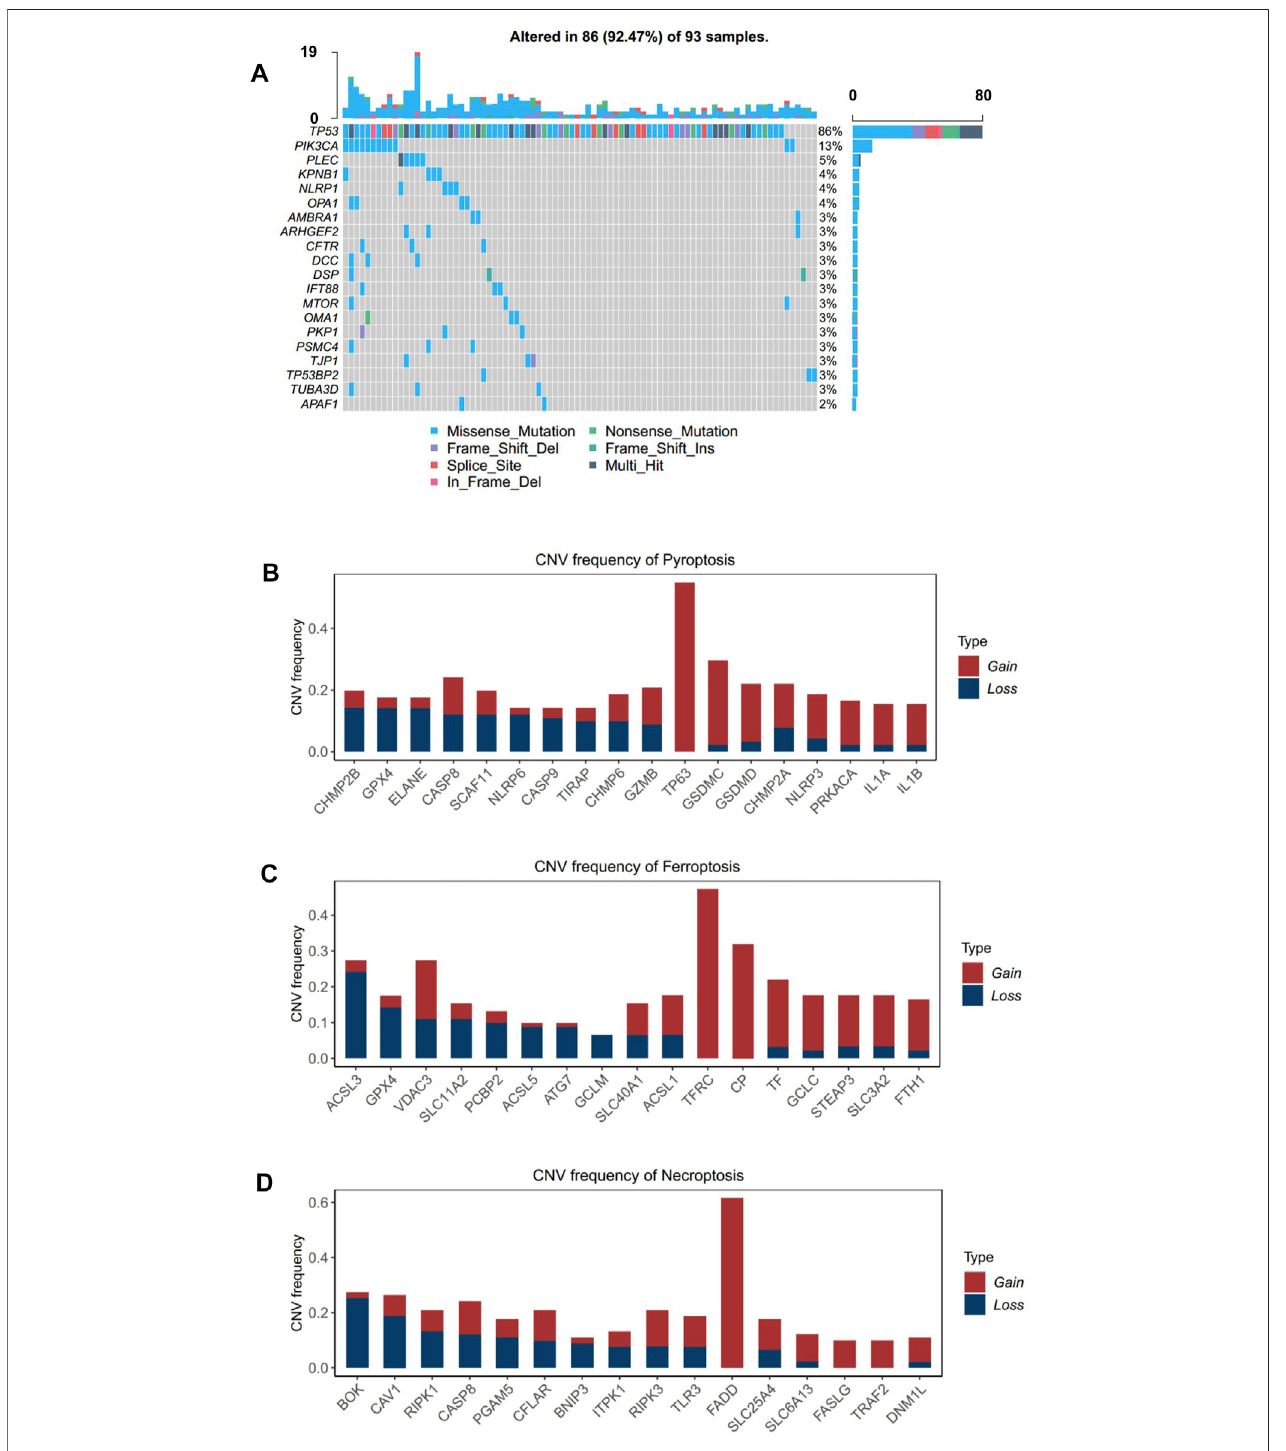
FIGURE 2 | Landscapeofgenetic alterations ofcelldeath genes inESCC. (A) Mutation frequencyofcelldeath genesin91patientswithESCCfromtheTCGA-ESCC cohort.Upper:thebarplotshowsthenumberofmutantgenesinindividualpatients.Right:thebarplotindicatestheproportionofeachvarianttype. (B – D) .CNVfrequencyof pyroptosis, (B) ferroptosis,and (C) necroptosis (D) intheTCGA-ESCCcohort.Theheightofthecolumnrepresentsthealterationfrequency.Variationcolorindicatestheclass of CNV (red for ampli fi cations and blue for deletions).